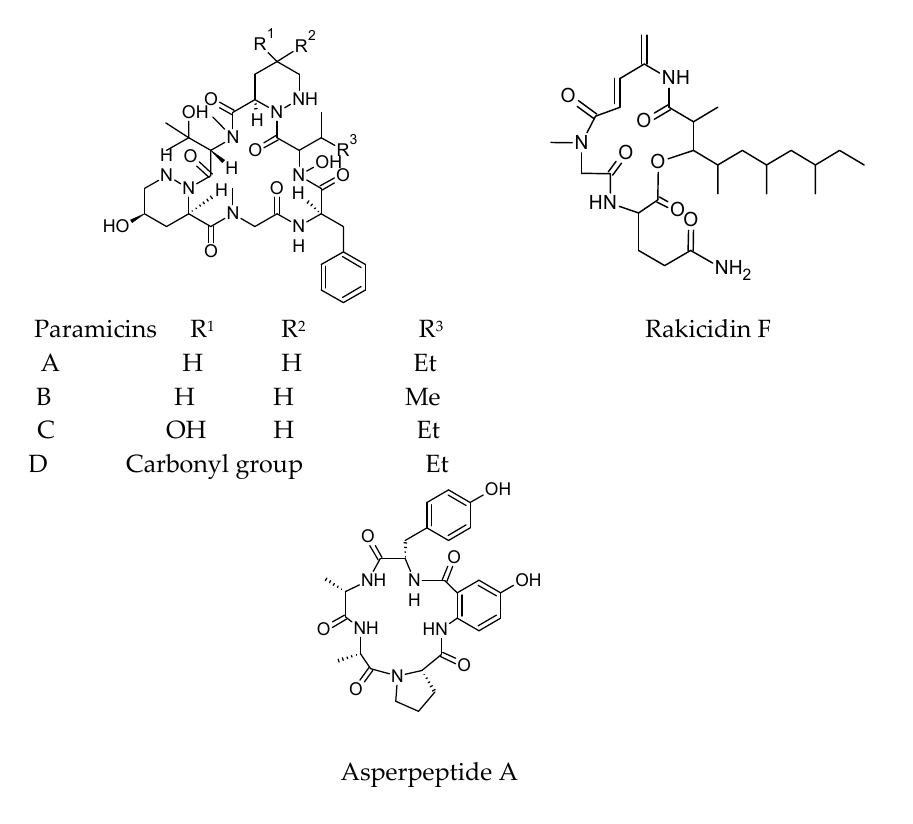
Figure 2. Recently isolated antibacterial cyclic peptides.